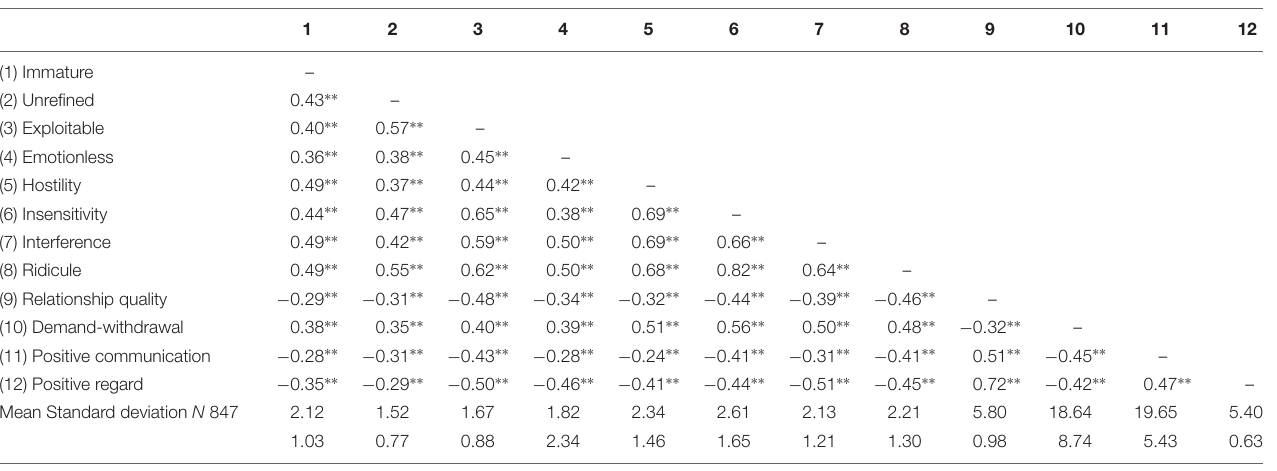
TABLE 3 | Study 2 descriptive statistics and zero-order correlations between the target version of the DIRRS and other study variables.